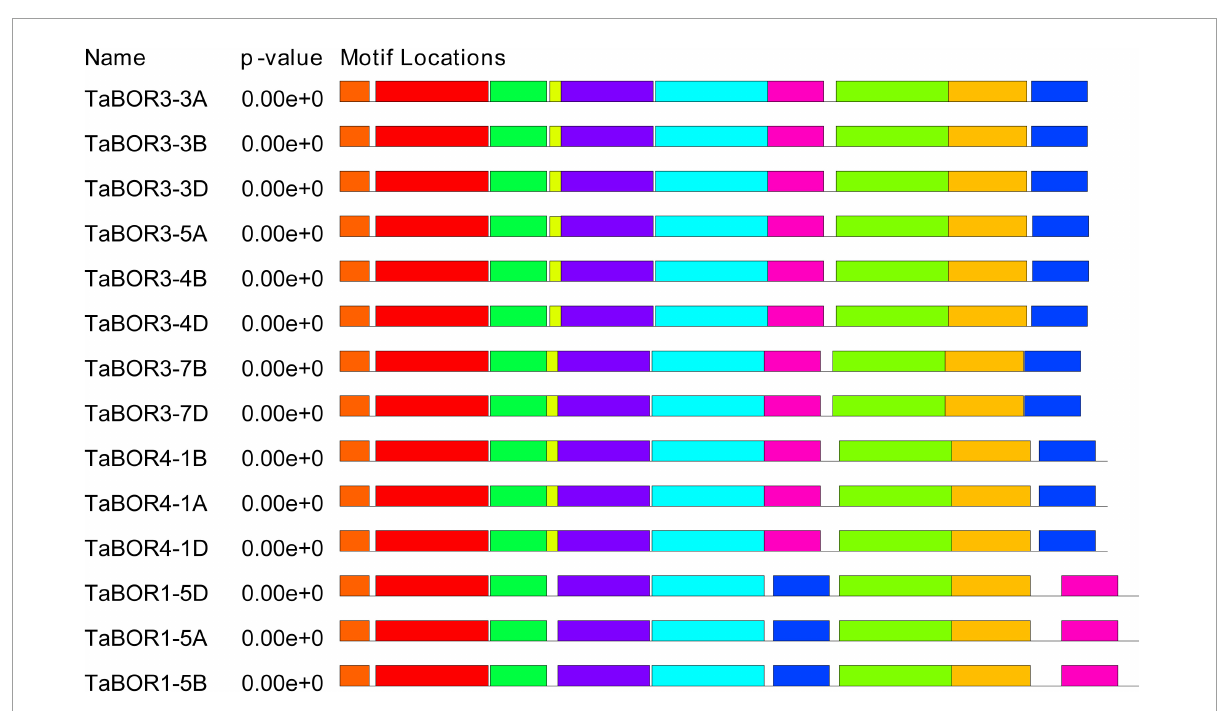
FIGURE3 Investigation of conserved motifs in TaBOR proteins by MEME. Different colors represent different